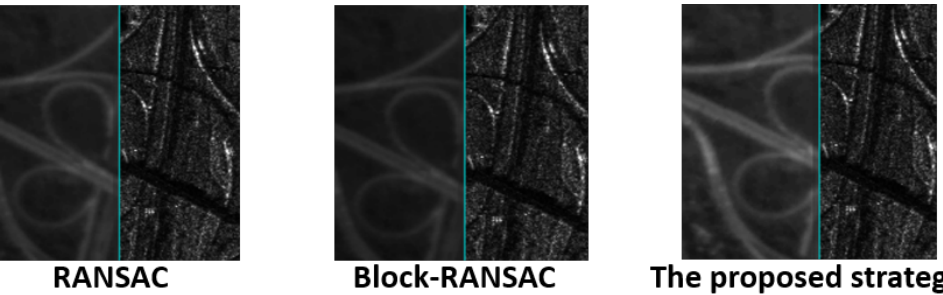
Figure 19. Details of image transformation relationships detected by RANSAC, Block-RANSAC and the proposed strategy in pair